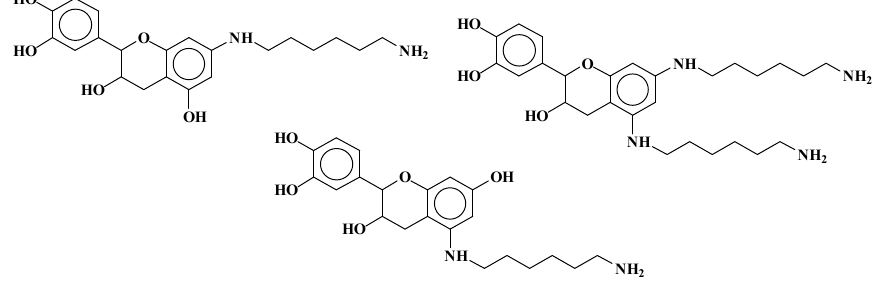
Figure 17. Covalently linked catechin A-ring-diamine structures observed by 13 C NMR.